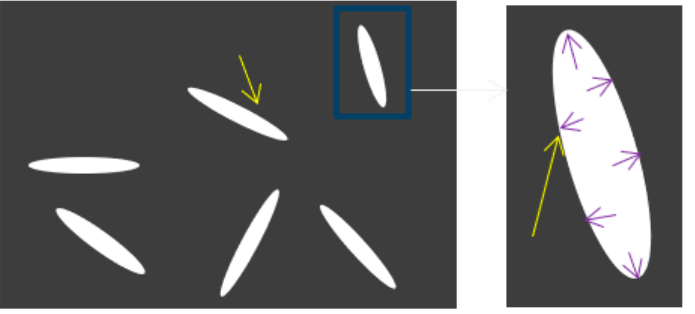
Figure 3. Schematic representation of concrete after corrosion, where the loading condition is shown in a partially enlarged crack (right).